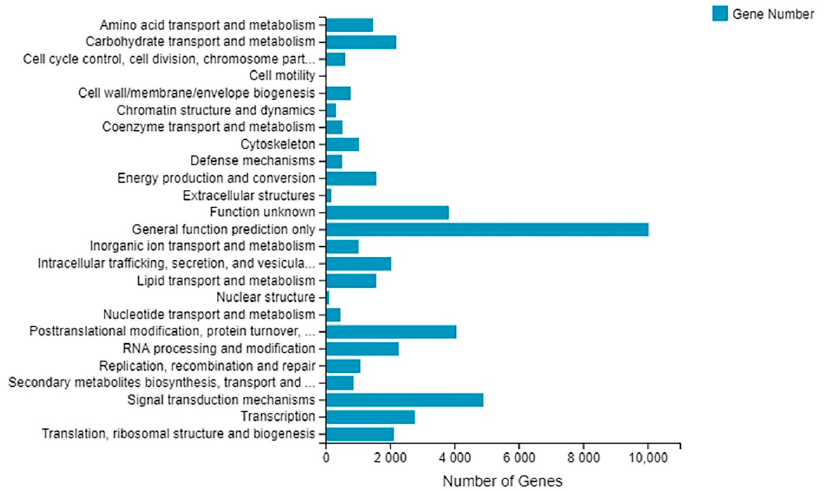
Figure 6. Histogram of KOG function classification of unigenes. The categories of the KOG are shown on y -axis and the x -axis represents the number of unigenes.